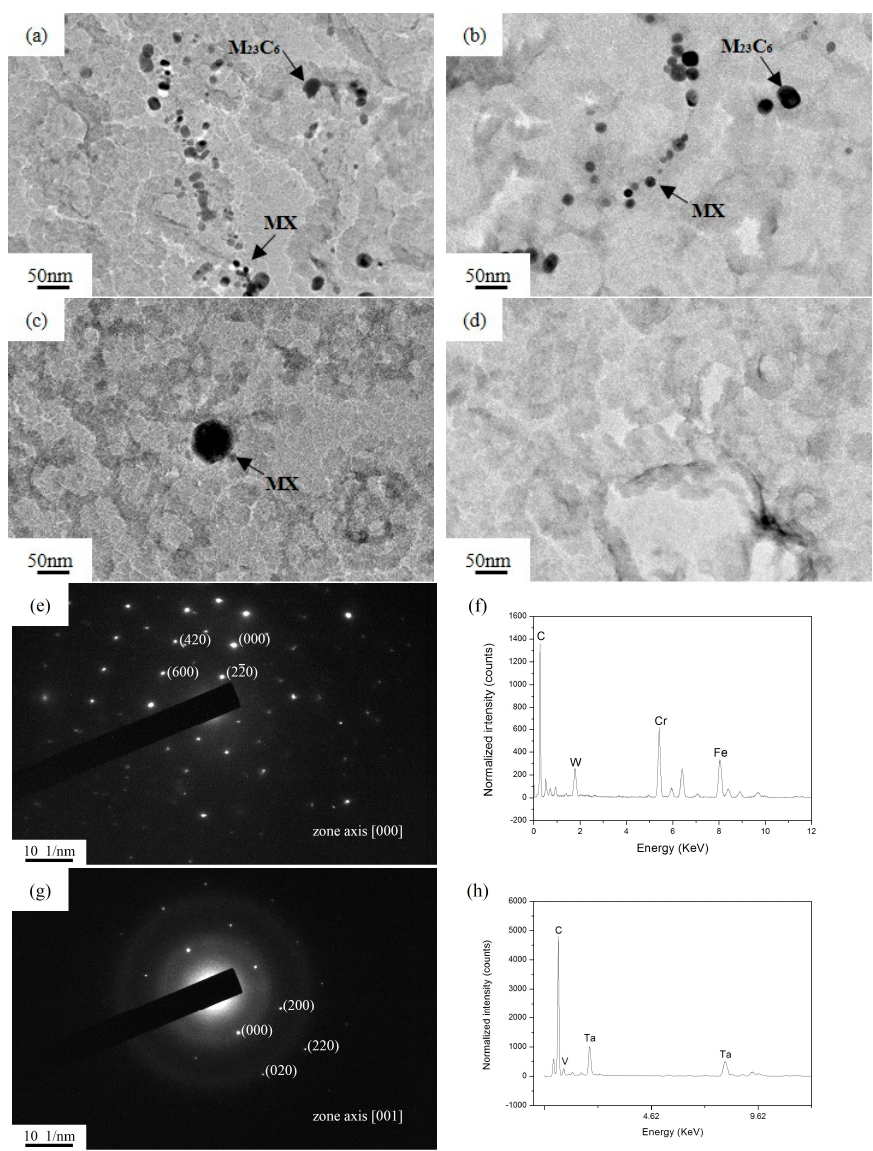
Figure 3. TEM micrograph of extraction replica, holding at: ( a ) 900 °C; ( b ) 1000 °C; ( c ) 1100 °C; and ( d ) 1200 °C for 400 s; ( e – h ): The selected area electron diffraction (SAED) pattern and the energy dispersive spectroscopy (EDS) analysis of M 23 C 6 and MX precipitates, respectively.